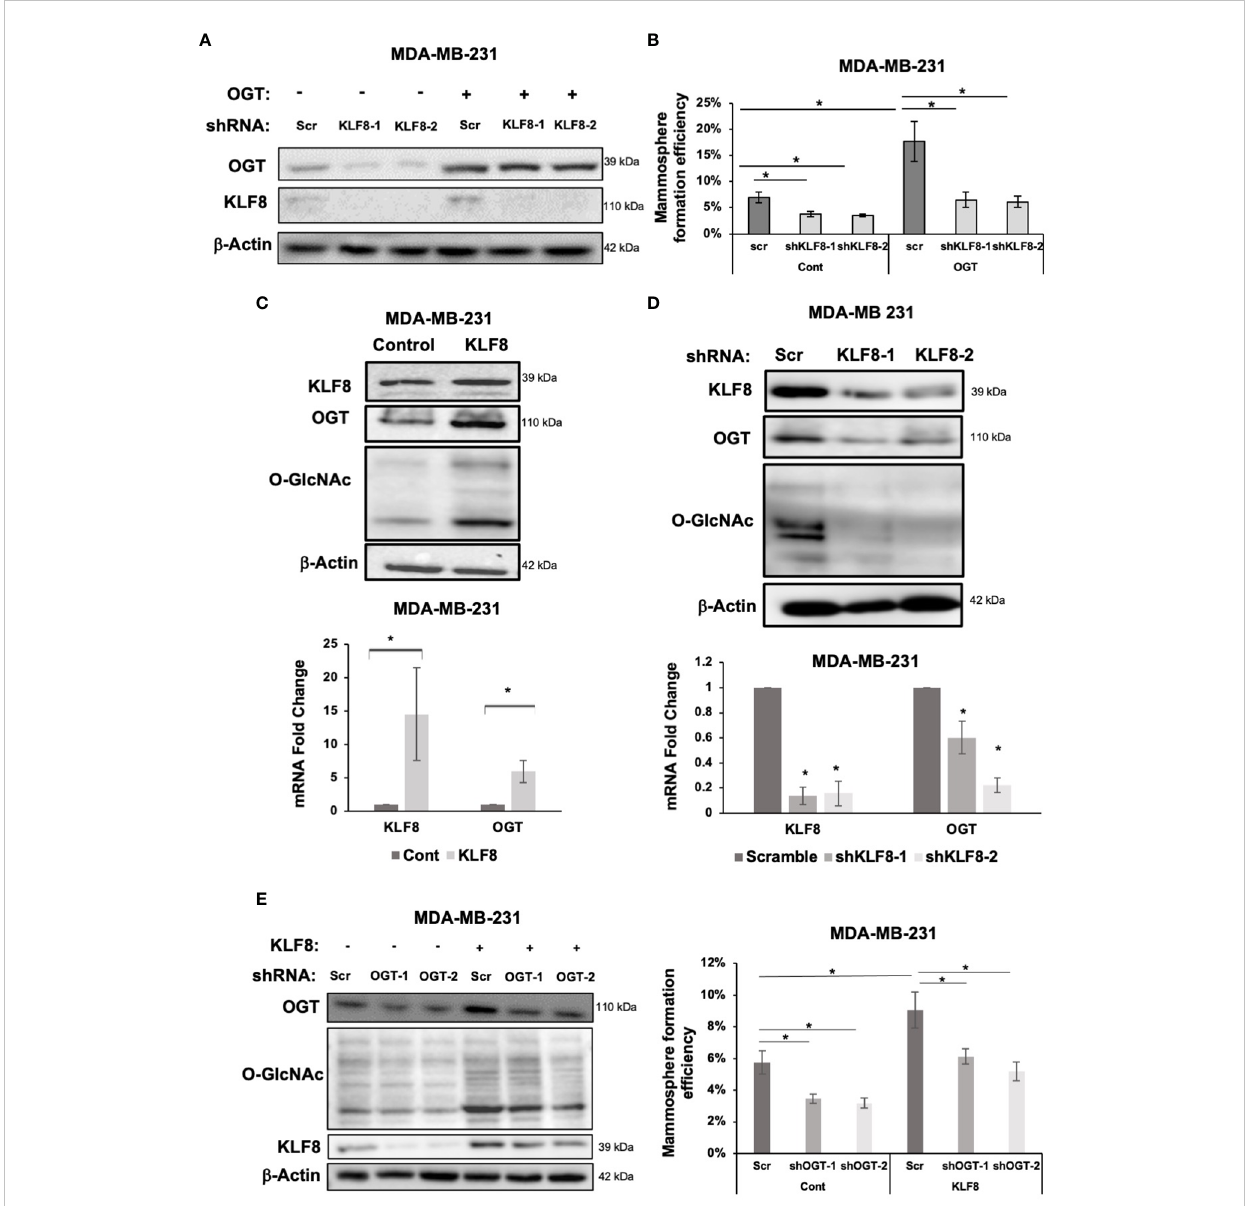
FIGURE 5 KLF8 and OGT/O-GlcNAc formed a potential feed-forward loop in breast cancer cells. (A) Lysates of MDA-MB-231 cells overexpressing control or OGT, transduced with control or KLF8 shRNA, were collected for immunoblot analysis using antibodies against indicated targets (B) Quanti fi ed graph showing mammosphere formation ef fi ciency of MDA-MB-231 cells overexpressing control or OGT, transduced with control or KLF8 shRNA, after 5- 7 days. (C) Lysates of MDA-MB-231 cells overexpressing control or OGT were collected for immunoblot analysis using indicated antibodies (top). Quanti fi ed graph showing relative mRNA level, detected by qRT-PCR, of KLF8 and OGT from MDA-MB-231 cells overexpressing control or OGT in mammosphere formation assay. (D) Lysates of MDA-MB-231 cells stably expressing control or KLF8 shRNA were collected for immunoblot analysis using indicated antibodies (top). Quanti fi ed graph showing relative mRNA level, detected by qRT-PCR, of KLF8 and OGT from MDA-MB-231 cells stably expressing control or KLF8 shRNA. (E) Lysates of MDA-MB-231 cells stably overexpressing control or KLF8, transduced with control of OGT shRNA, were collected for immunoblot analysis using indicated antibodies. (B) Quanti fi ed graph showing mammosphere formation ef fi ciency of MDA-MB-231 cells overexpressing control or KLF8, transduced with control of OGT shRNA, after 5-7 days in mammosphere formation assay. Student t test reported as mean ± SEM,